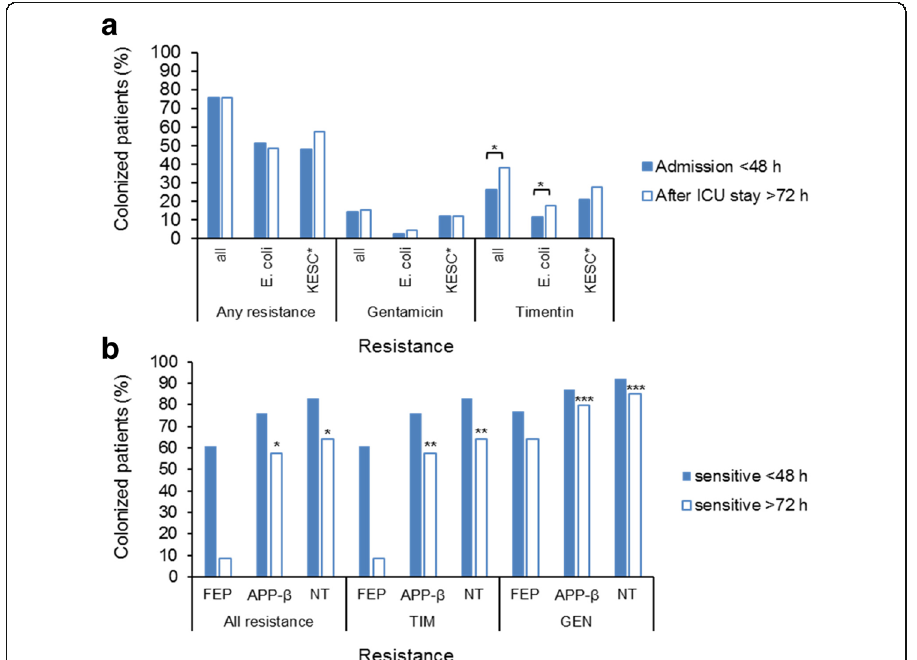
Fig. 1 Variation in colonization patterns before and after ICU stay. a Rates of colonization with antibiotic-resistant species at admission and after ICU stay. b Change in susceptibility rates after ICU stay in different treatment cycles. Proportion of the entire study group of patients ( n =206) with positive cultures. “ Any resistance ” indicates any bacterial growth on antibiotic supplemented media. “ All resistance ” indicates any growth on ChromAgar ™ supplemented with vancomycin only (to exclude Gram-positive species). *KESC, Klebsiella , Enterobacter , Serratia , Citrobacter spp. as identified on colorimetric media ChromAgar ™ and confirmed by MALDI-TOF [16] as previously described [5]. Asterisks (*, **, ***) above bar charts indicate significant differences ( p